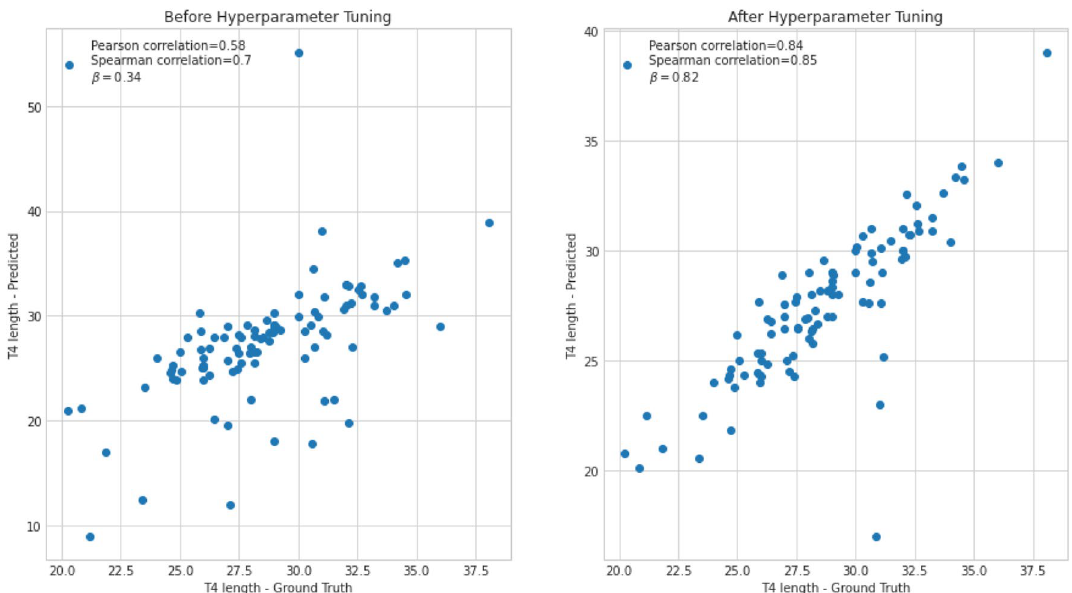
Figure 6. Scatter plots of ground truth T4 body length and predicted length by segmentation model. Pearson correlation coefficient, spearman correlation coefficient, and beta coefficient from linear regression for model with default hyperparameter setting (left) were 0.58, 0.7, 0.34, and 0.84, 0.85, 0.82 for model with tuned hyperparameters